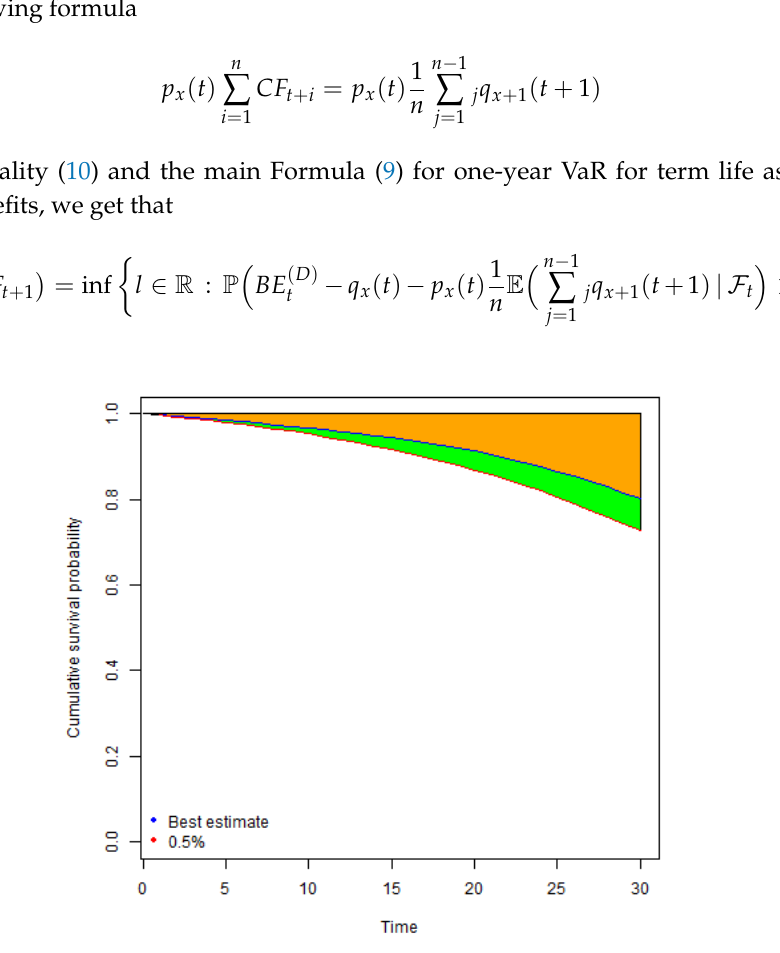
Figure 11. Calculation of Best Estimate (orange area) and run-off VaR (green area) for term life assurance with linearly decreasing sum insured for the policy term of 30 years. The red line represents 0.5% confidence interval of survival probability, which is equivalent to 99.5% confidence interval of the cumulative death